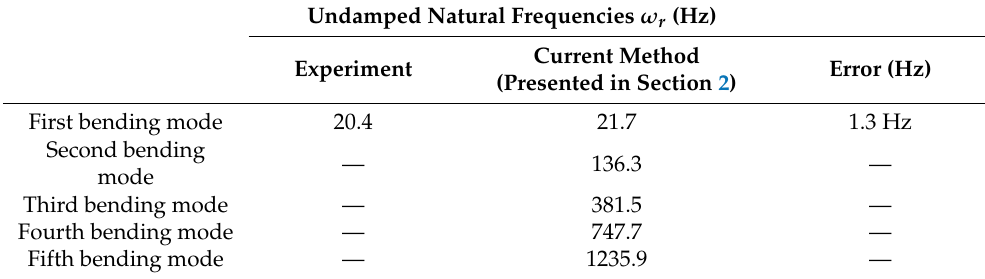
Table 2. Comparison of undamped natural frequencies between the presented method and the experiment.